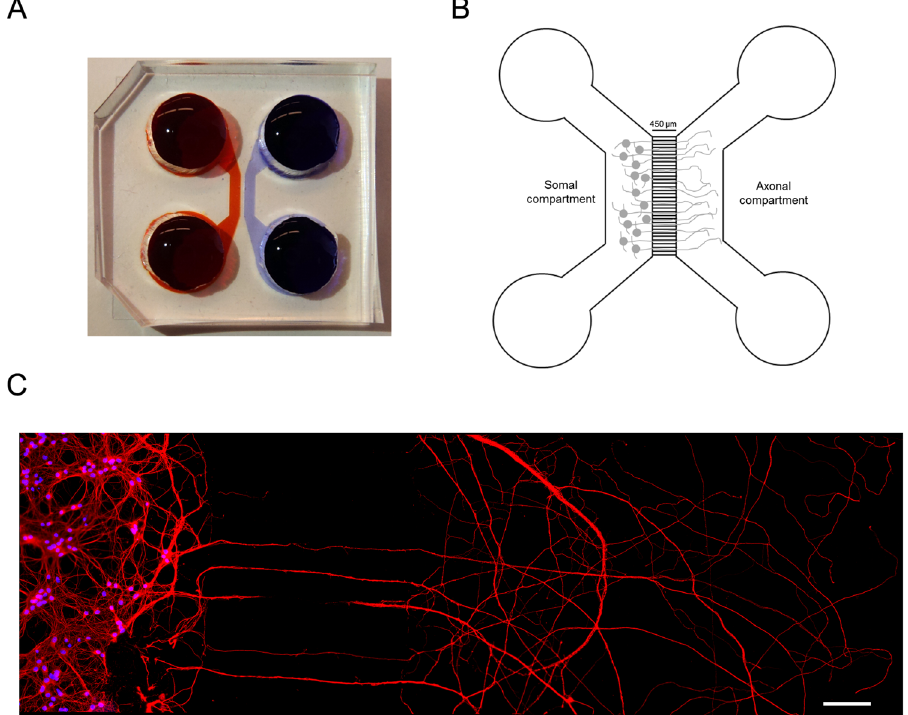
Figure 2. Microfluidic chambers for culturing CNS neurons. ( A , B ) Representative model of a microfluidic chamber. These small systems (20 mm × 25 mm) consist of a molded PDMS chamber placed against a glass coverslip. The microfluidic device consist of a somal compartment (red) and an axonal compartment (blue), each 1.5 mm wide, 7 mm long, which are separated by microgrooves (450 μ m long, 10 μ m wide). Neurons are plated in the somal compartment and between days 4–5 the axons pass through the microgrooves into the axonal compartment. The height difference between microgrooves (3 μ m) and compartments (100 μ m) combined with a minimal volume difference between the two sides (~25 μ l) leads to a fluidic isolation between the two compartments. ( C ) Representative image of cortical neurons cultured in microfluidic chambers. At DIV5-6, cortical neurons were immunostained for tubulin (red) and stained for DNA (blue). The image shows that cell bodies are restricted to the somal compartment while in the opposite compartment only axons are observed. Thus microfluidic chambers allow axonal isolation and specific manipulation of distal axons without soma contribution (for further details see the Material and methods section and ref. 17). Contiguous images were taken from a random area of the microfluidic chamber using an AxioObserver Z1 fluorescent microscope with a PlanApochromat 20 × objective and assembled into a single image using the ZEN 2011 software. The scale bar is 100 µ